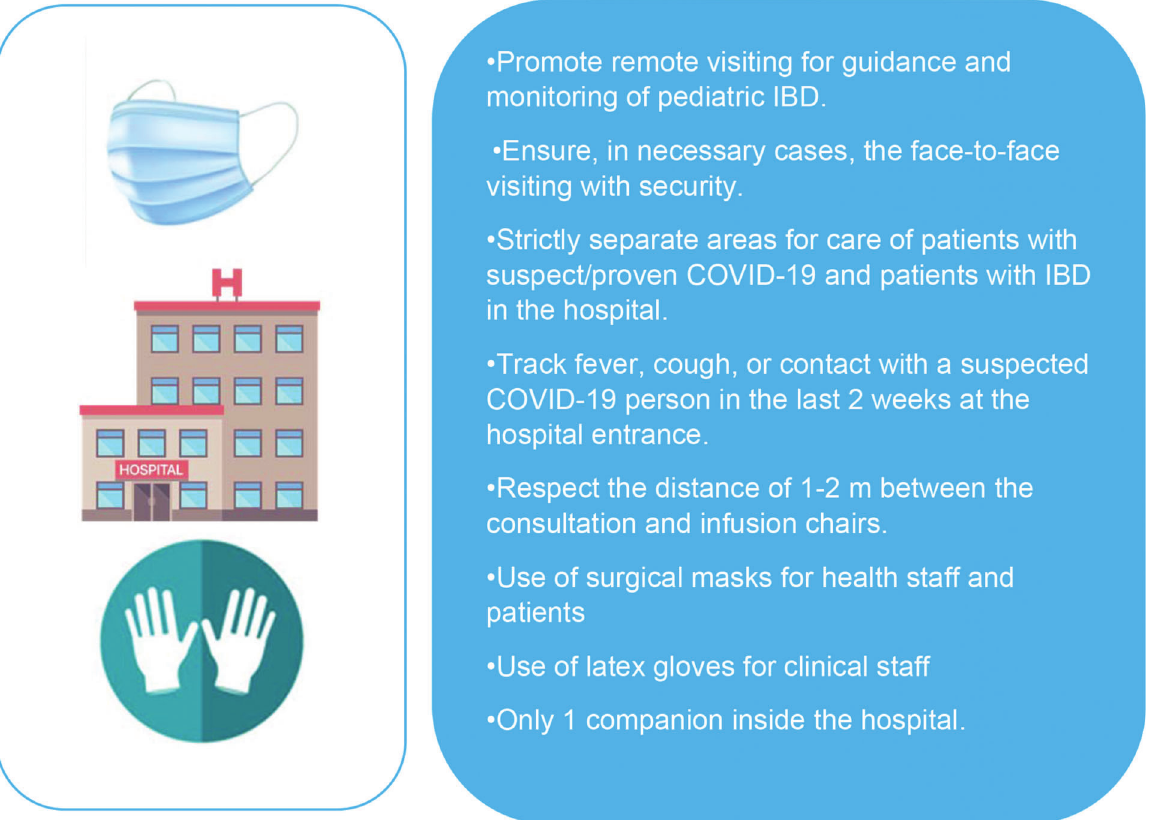
Figure 2 - Remote and face-to-face monitoring of pediatric IBD during the pandemic COVID-19. Modified by Danese et al. (25), Turner et al. (26), and Fiorino et al.